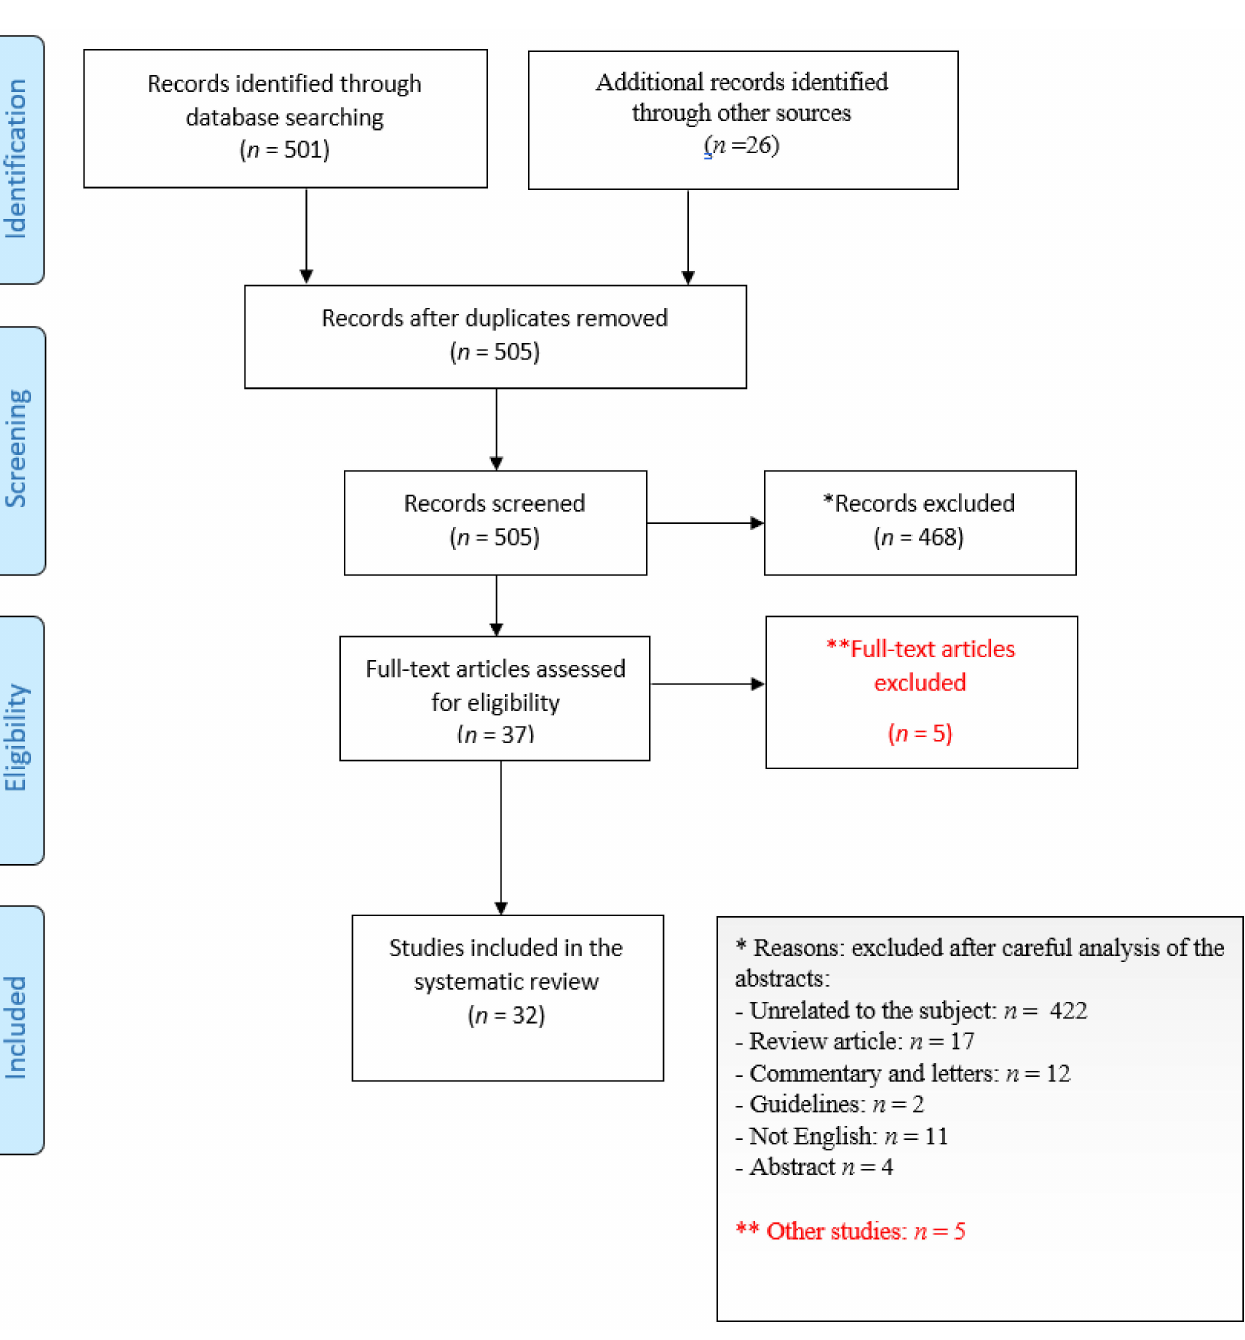
Figure 1. PRISMA flow diagram of study